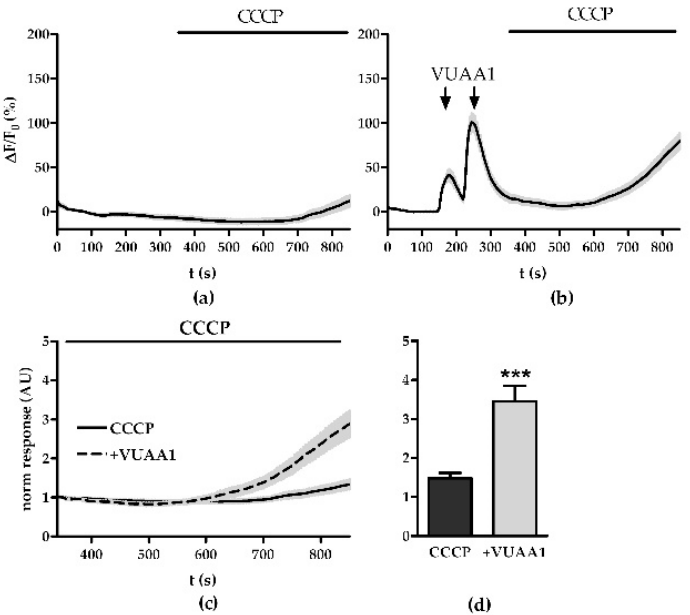
Figure 1. CCCP can release mitochondrial Ca 2+ imported due to OR activity: ( a , b ) averaged time course of the change in Ca 2+ fluorescence intensity Δ F/F0 in OSNs evoked by application of 1 µM CCCP under control conditions ( a ) or after a double stimulation with 30 µM VUAA1 ( b , arrows); ( c ) comparison of normalized increase in Ca 2+ fluorescence responses of OSNs with and without previous VUAA stimulation; ( d ) terminal Ca 2+ responses from ( c ). Data represent mean ± SEM (CCCP, n = 48, CCCP + VUAA1, n = 49), Student’s unpaired t -test, *** p < 0.001.